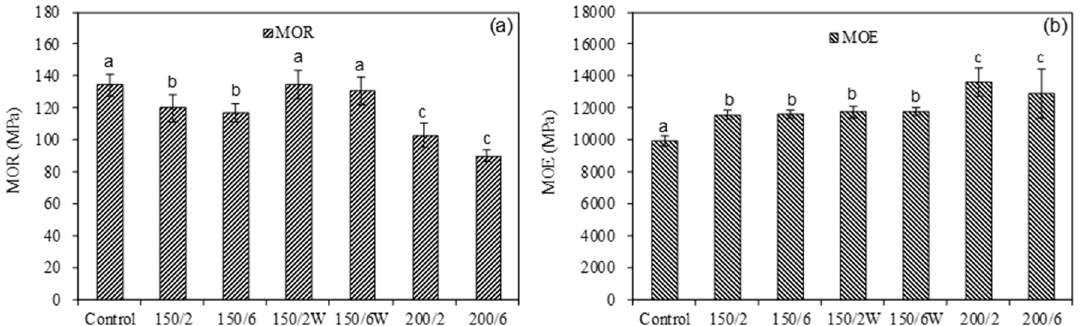
Figure 3. MOR ( a ) and MOE ( b ) of the control and modified groups. Bars showing different letters indicate significant difference ( p < 0.05) according to Duncan’s multiple range tests.